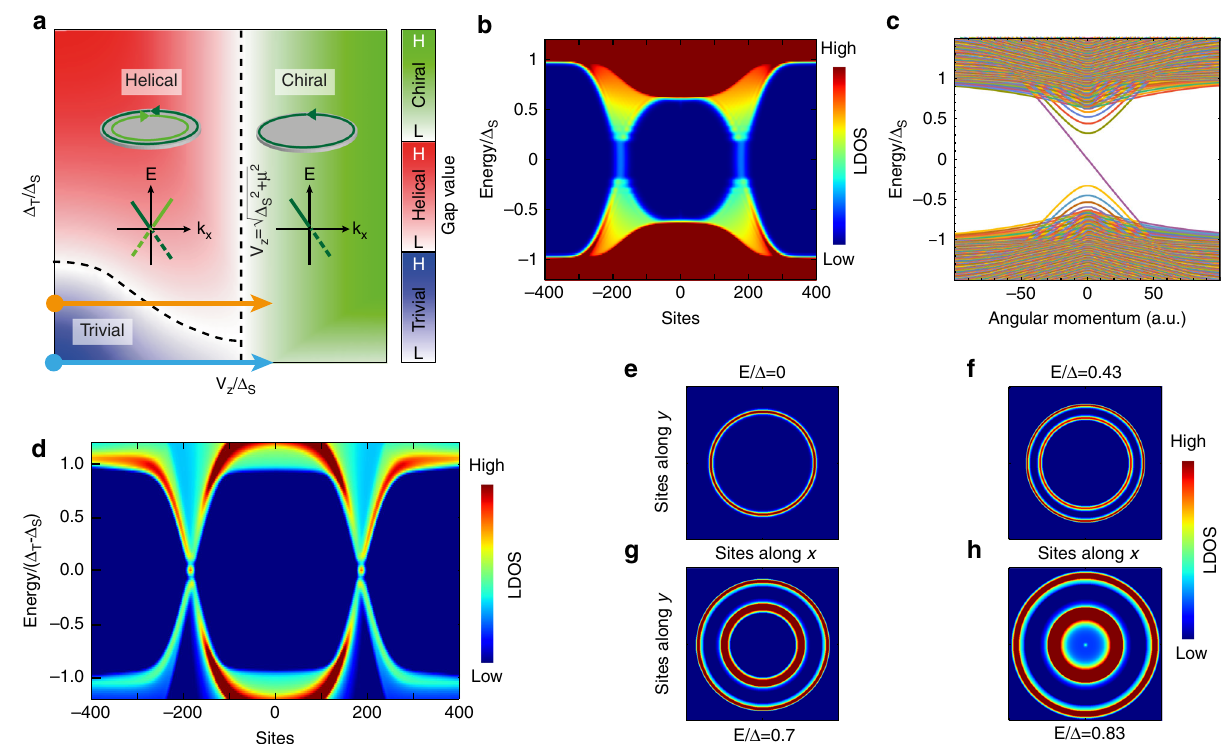
Fig. 3 Theoretical calculations. a Phase diagram of 2D topological superconductivity as a function of the Zeeman fi eld V z and the triplet order parameter amplitude Δ T . The black dashed lines show the transitions between the trivial and helical phases, as well as the transition between the helical and chiral phases. The insets show the typical behavior of the edge states for the helical case (with two counter-propagating edge states) and the chiral case (only one edge state whose chirality is determined by the orientation of the magnetic fi eld). The color code corresponds to the values of the gap in each phase with one color for each phase. b Real space tight binding calculation of ρ ( r , E ) showing a Majorana edge state dispersing throughout the gap (parameters used for the calculation: t = 100, μ = 50, α = 200 and Δ S = 140). No triplet pairing was used: Δ T = 0. The diameter of the system is D = 500 sites. The Zeeman potential is given by V z ( r ) = 120(1 − tanh( r − R c )/ w ), with R c = D /2 and w = 0.14 D . c Energy dispersion as function of the angular momentum E ( k θ ) with the same parameters used for the tight binding calculation in b showing a Majorana branch closing the gap. d Real space tight binding calculation of ρ ( r , E ) in the presence of a triplet pairing (Parameters used for the calculation: t = 100, μ = 50, Δ S = 150, Δ T = 60 and α = 0). The Zeeman potential is the same as in b . Note that in all our numerical calculations, the X-shape features originate from a real space partial gap closing. This can be traced back to the smoothness of the Zeeman fi eld decaying over a scale w (cid:4) k (cid:3) 1 F . In the more realistic limit, w (cid:1) R c < ξ , we expect that only the edges states will cross the gap and give rise to these X-shape features. e – h Calculated LDOS with the same parameters than in d for 4 different energies: E / Δ = 0, 0.43, 0.7, and